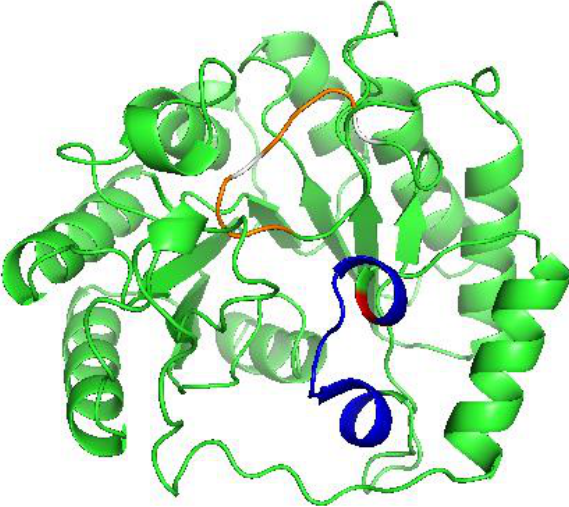
Figure 2. A model of human LIAS modeled using Phyre 2 software. Highlighted in blue is the position of the auxiliary binding motif, with C106 highlighted in red. The location of the reducing cluster motif is shown in orange, with C137 and C141 highlighted in white.